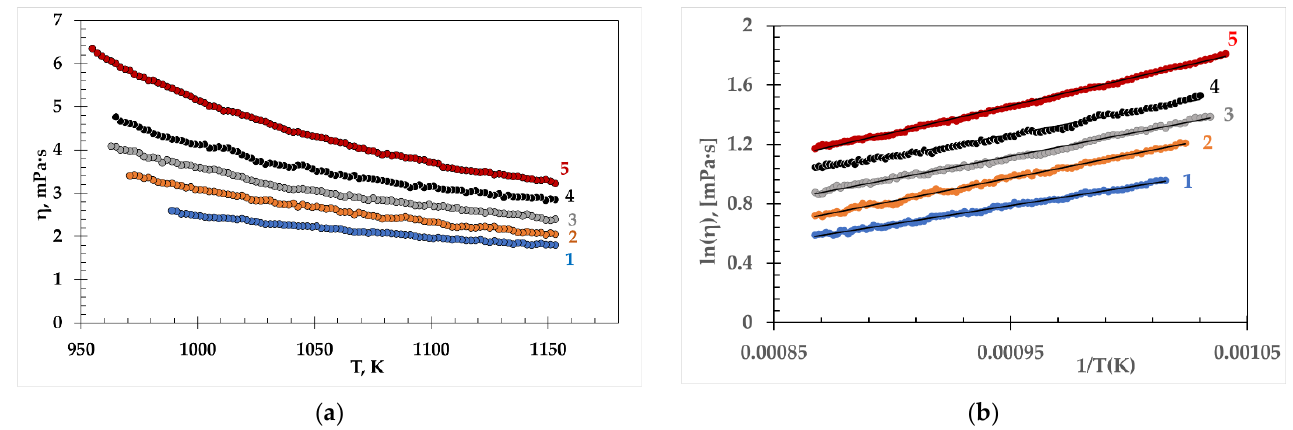
Figure 5. Viscosity of molten (NaF - KF) eut containing NdF 3 (mol.%): 1—0, 2—5, 3—7.5, 4 – 10, 5—1; measured ( a ) and calculated according to Equation (3) ( b ).